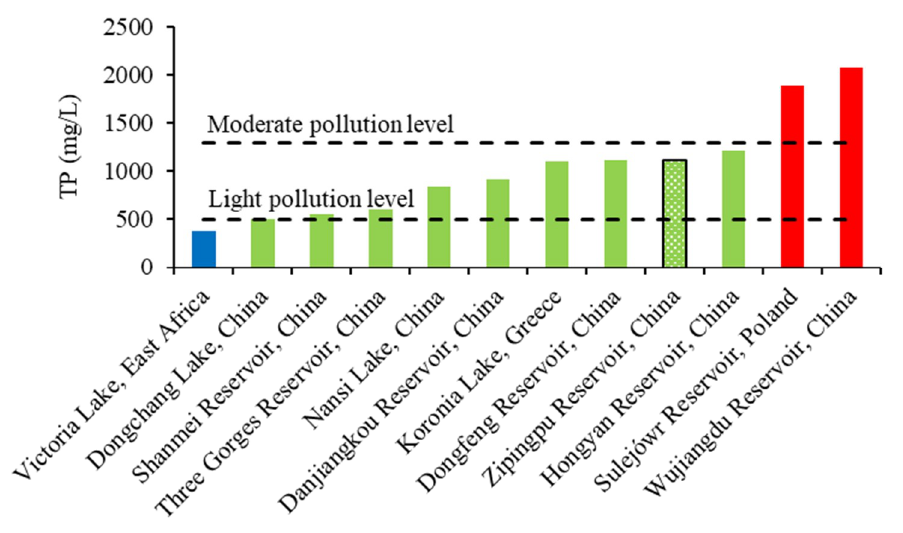
Figure 5. Sediment TP contents in different reservoirs and lakes.